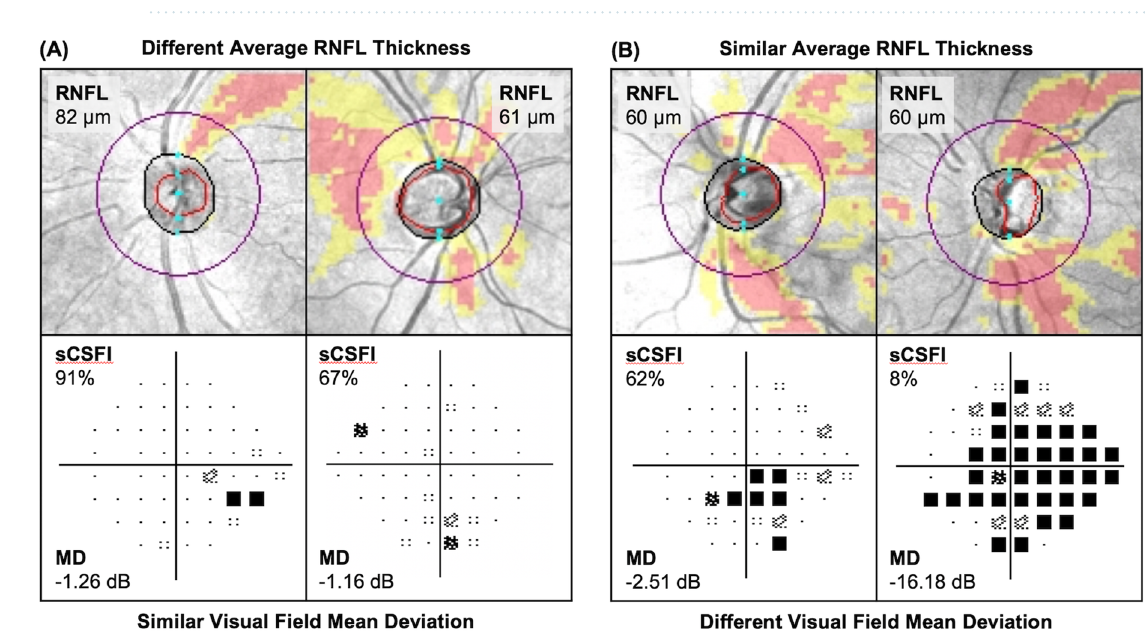
Figure 3. Examples of how simplified combined structure function index (sCSFI) captures the extent of glaucomatous damage across the spectrum of the disease. ( A ) In the first example, two eyes with similar visual field mean deviation (MD) show markedly different average retinal nerve fiber layer (RNFL) thicknesses, but this difference was apparent on the sCSFI. ( B ) In the second example, two eyes with similar average RNFL thicknesses show markedly different visual field MD, which was also different on the